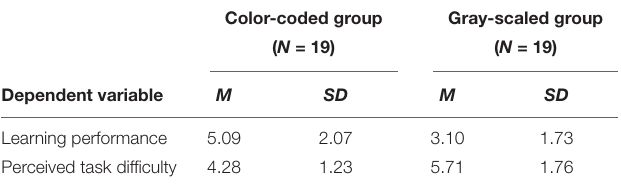
TABLE 2 | Means and standard deviations of learning performance and perceived task difficulty.